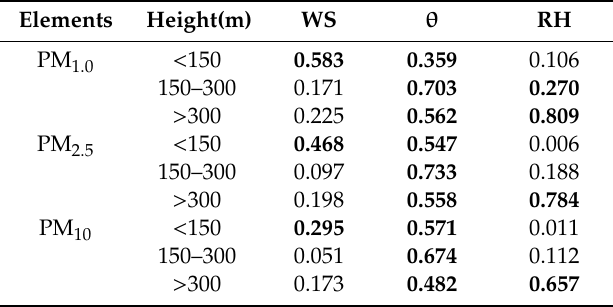
Figure 8. Wind vector in the boundary layer above Xiaotang during the observation periods (from 15:00 on 13 November to 03:00 on 15 November 2019).